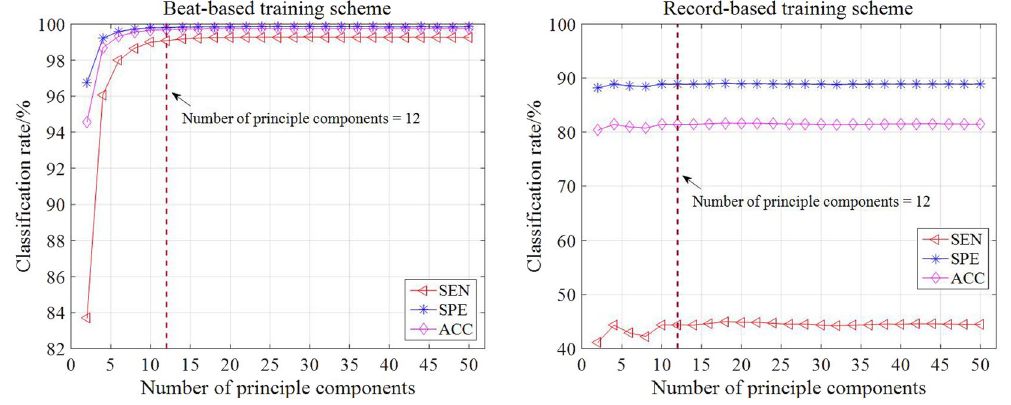
Figure 5. Classification rates with different numbers of principle components.